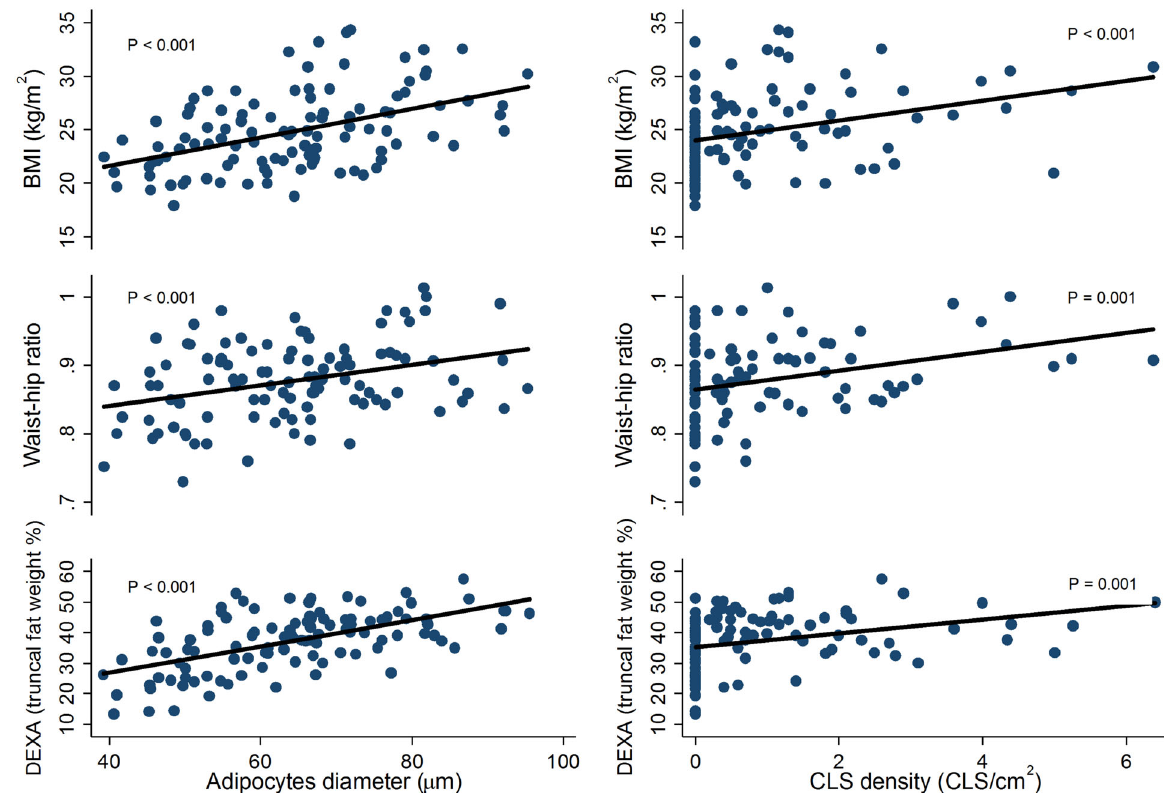
Fig. 4 Scatterplots and linear relationships of anthropometric measures ( y -axis) and adipocyte diameter ( x -axis, left panel ) or CLS density ( x - axis, right panel ). The P -values are obtained from tests of no linear